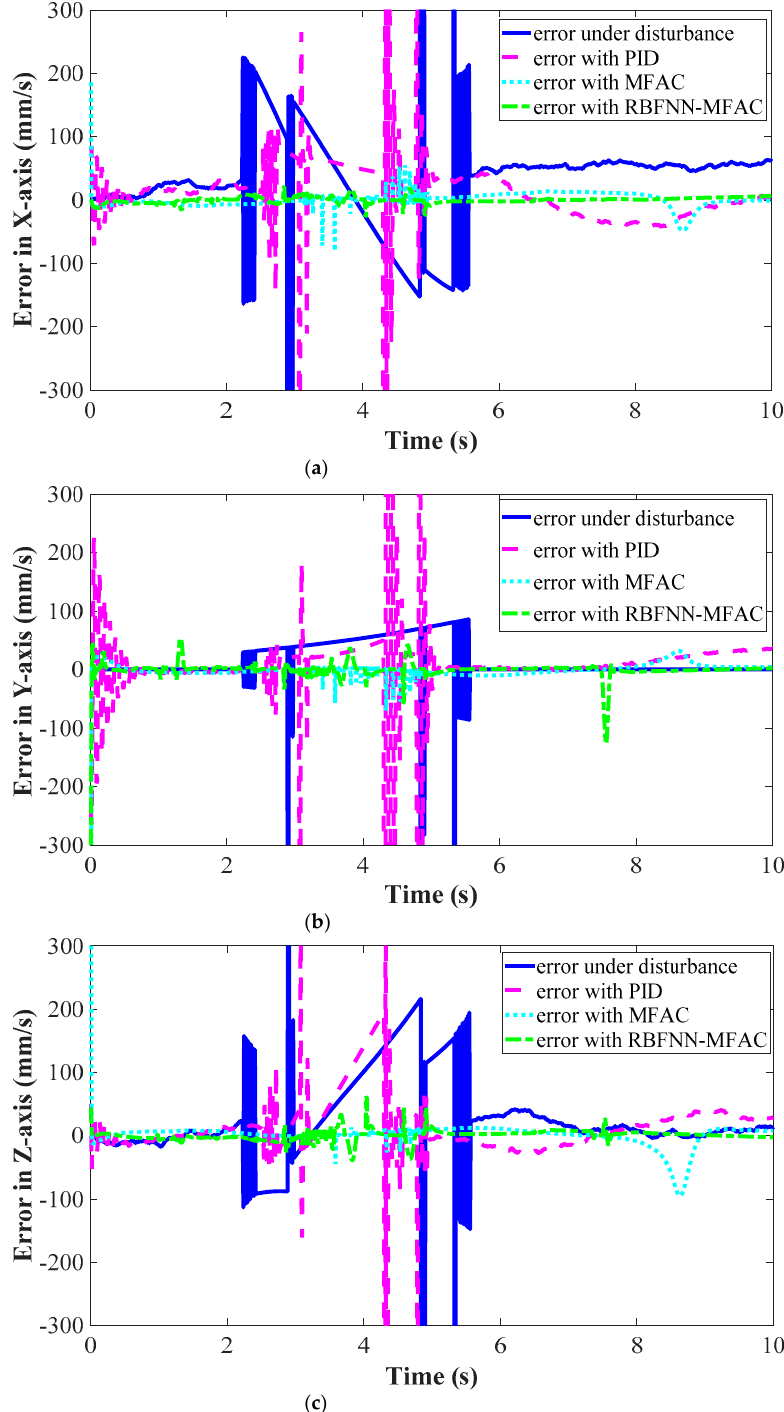
Figure 15. Speed Tracking Error along Various Axes of Cartesian Coordinates. ( a ) Speed Tracking Error along x Axis; ( e vx : average error with PID is 39.4 mm/s, average error with MFAC is 8.0 mm/s, average error with RBFNN-MFAC is 3.4 mm/s). ( b ) Speed Tracking Error along y Axis; ( e vy : average error when PID is 49.4 mm/s, average error with MFAC is 7.2 mm/s, average error with RBFNN- MFAC is 5.2 mm/s). ( c ) Speed Tracking Error along z Axis; ( e vz : average error with PID is 41.3 mm/s, average error when MFAC is 9.5 mm/s, and the average error with RBFNN-MFAC is 5.3